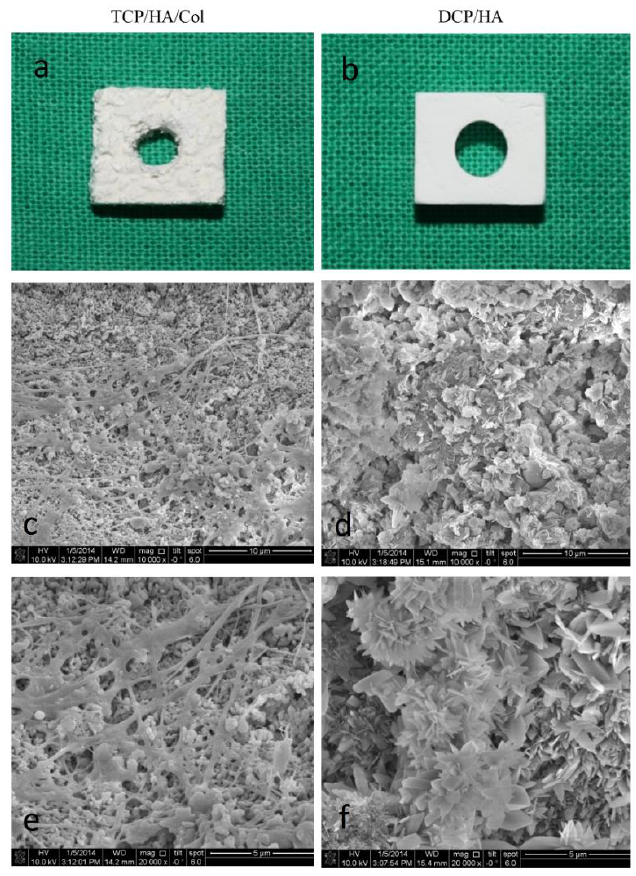
Figure 1. Gross and scanning electron microscopic images of grafts used in this study. ( a ) Gross image of TCP / HA / Col used in this study. A rougher and more irregular surface can be observed for TCP / HA / Col than for DCP / HA. ( b ) Gross image of DCP / HA grafting material used in this study. ( c – f ) Microphotographs, obtained using scanning electron microscopy (SEM), showing the surface characteristics of the cross-sections of the TCP / HA / Col ( c , e ) and DCP / HA ( d , f ) grafting materials. ( c , d ): 10,000×; ( e , f ): 20,000×.